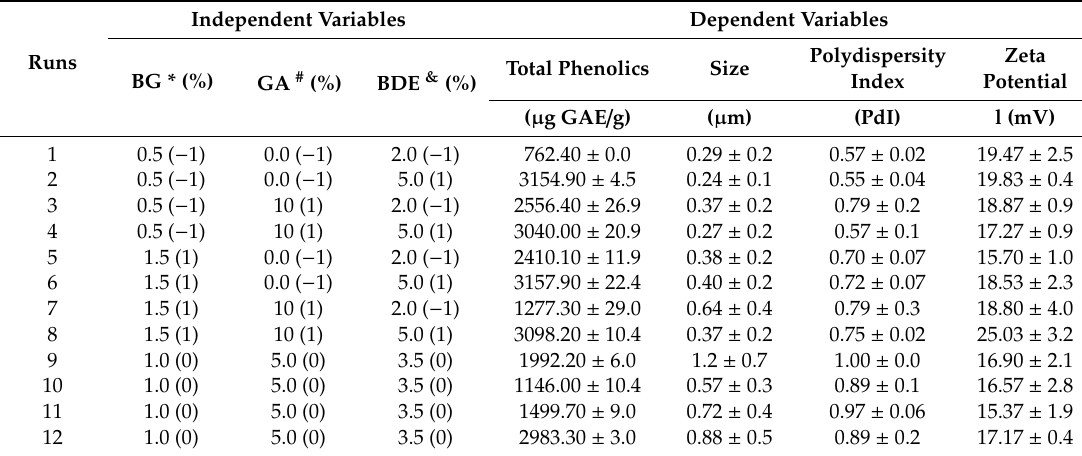
Figure 2. Estimated e ff ects of the concentrations of β -glucan (BG), gum arabic (GA) and B. dracunculifolia extract (BDE) on the total phenolic content of the microparticles at the 95% ( A ) and 85% ( B ) confidence levels. Table 1. Experimental arrangement based on a statistical 2 3 full factorial